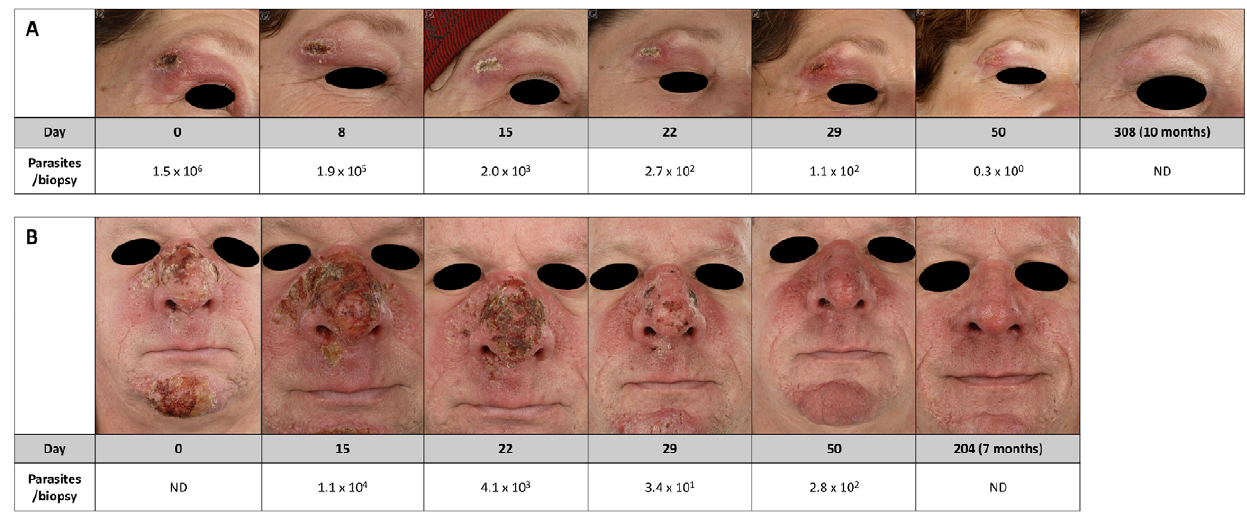
Figure 1. Clinical follow-up of CL lesions. Photographs of two selected lesions in relation to parasite loads in skin biopsies of two CL patients treated with miltefosine from the start of treatment until end of follow-up: A) L. major infection, B) L. infantum infection. ND=not